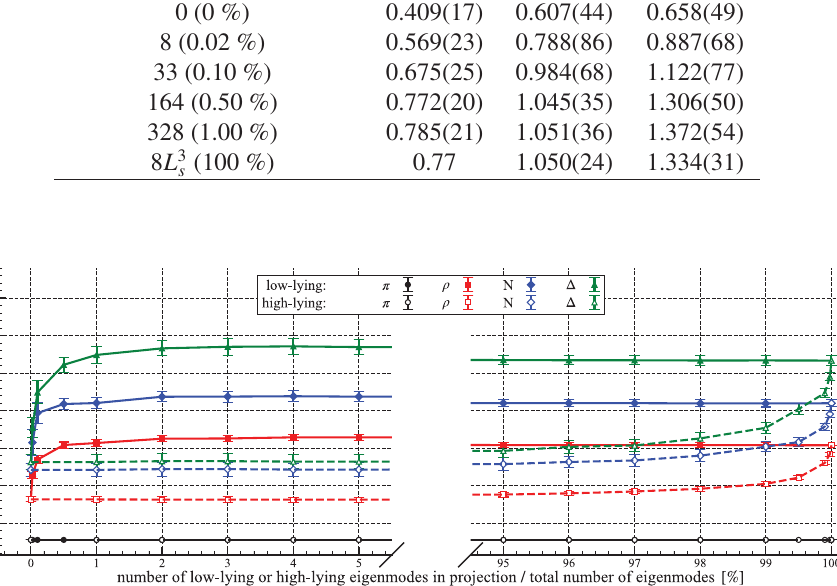
Table 1. Hadron masses under the eigenmode projection with low-lying FP eigenmodes. num. of low-lying FP modes